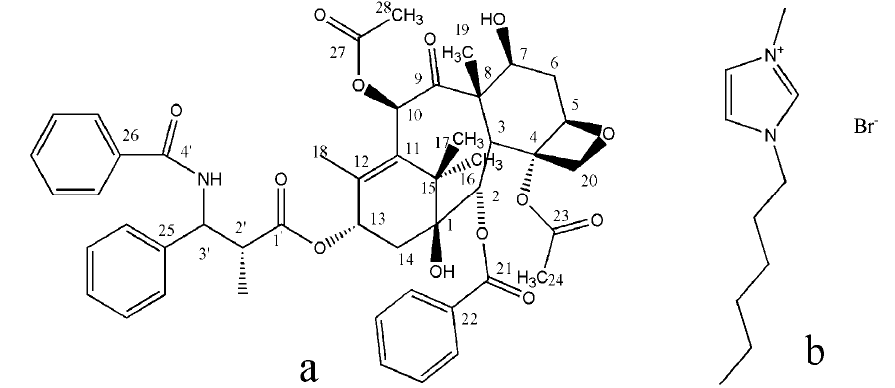
Figure 1. ( a ) Chemical structure of the paclitaxel. ( b ) Chemical structure of the HMImBr.